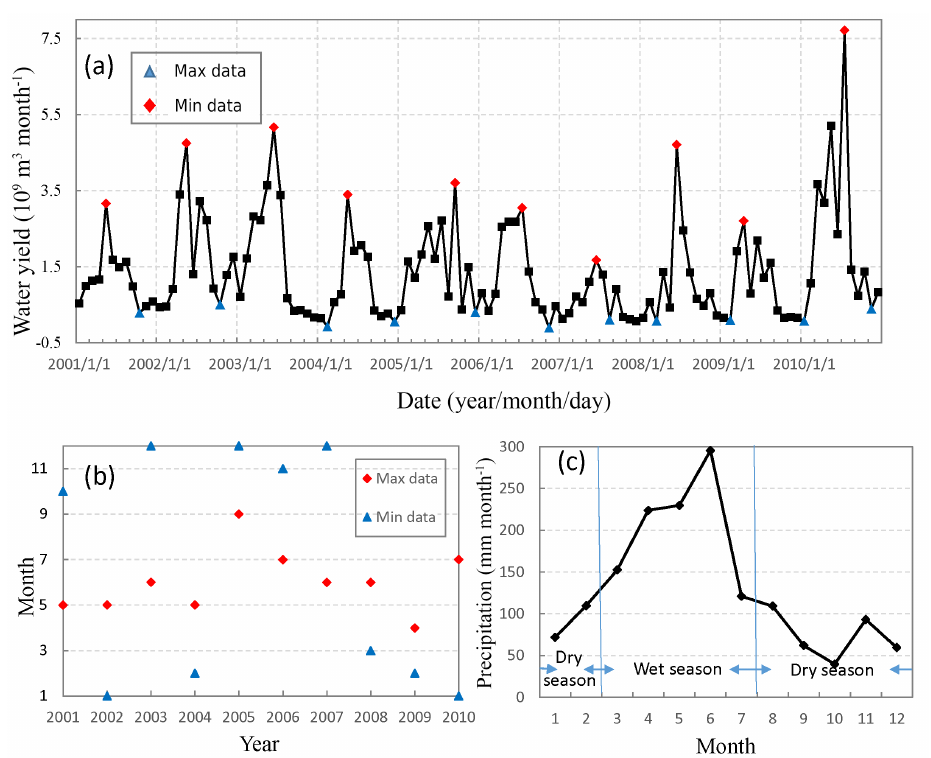
Figure 7. (a) The monthly mean water yield for each month from January 2001 to December 2010 produced by the PLUZ. (b) Maximum and minimum water yield month distributed from 2001 to 2010. (c) The mean monthly precipitation from 2001 to 2010 at Nanchang meteorological station derived from China’s meteorological networks. Max data and min data represent the monthly maximum water yield and monthly minimum water yield in the particular year,